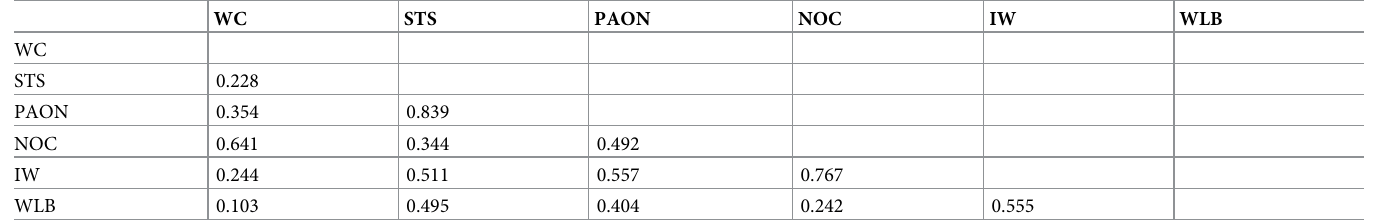
Table 4. HTMT ratio of latent